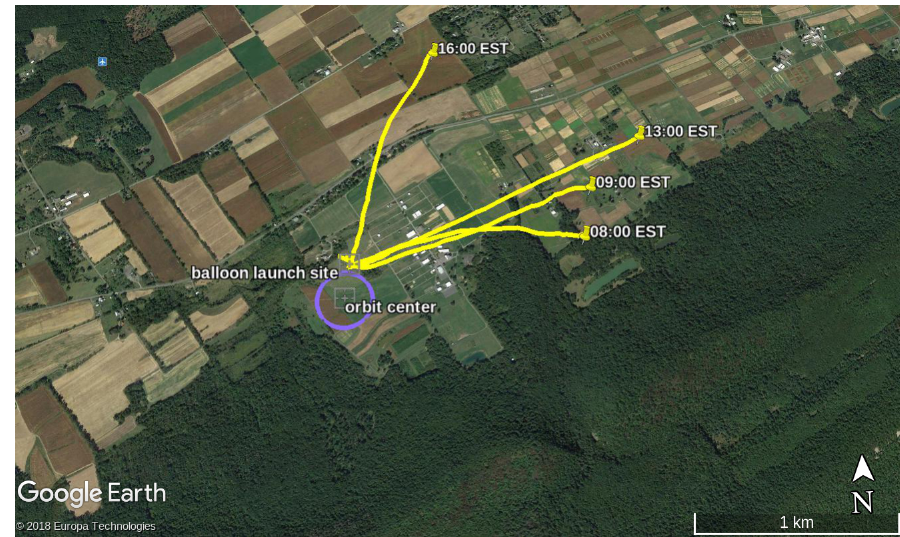
Figure 11. Aerial view of the test area showing the balloon trajectories and aircraft orbit